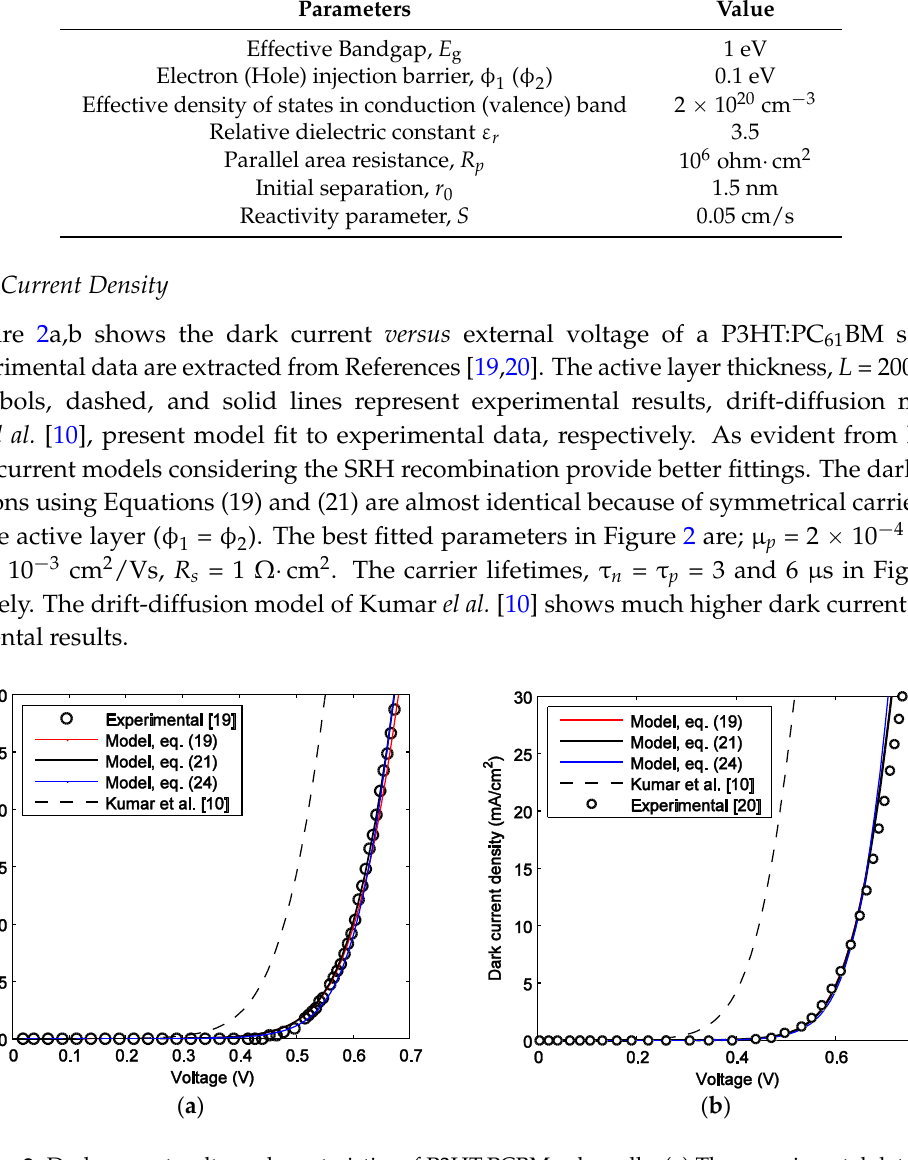
Figure 3. Dark current-voltage characteristics of a PTB7:PC 71 BM solar cell. The dark current is almost inversely proportional to the carrier lifetimes and it exponentially increases with increasing the injection barrier heights as evident from Equations (21) and (24). However, the effects of carrier mobilities on the dark current are not explicitly understandable from these equations. Therefore, it is instructive to show their effects through model calculations. The effects of carrier mobilities on the dark current in P3HT:PCBM solar cells are shown in Figure 4. All the parameters in Figure 4 are the same as in Figure 2. The dark current slightly decreases with decreasing the carrier mobility up to 10 −4 cm 2 /Vs whereas it decreases abruptly by reducing the mobility below 10 −4 cm 2 /Vs.